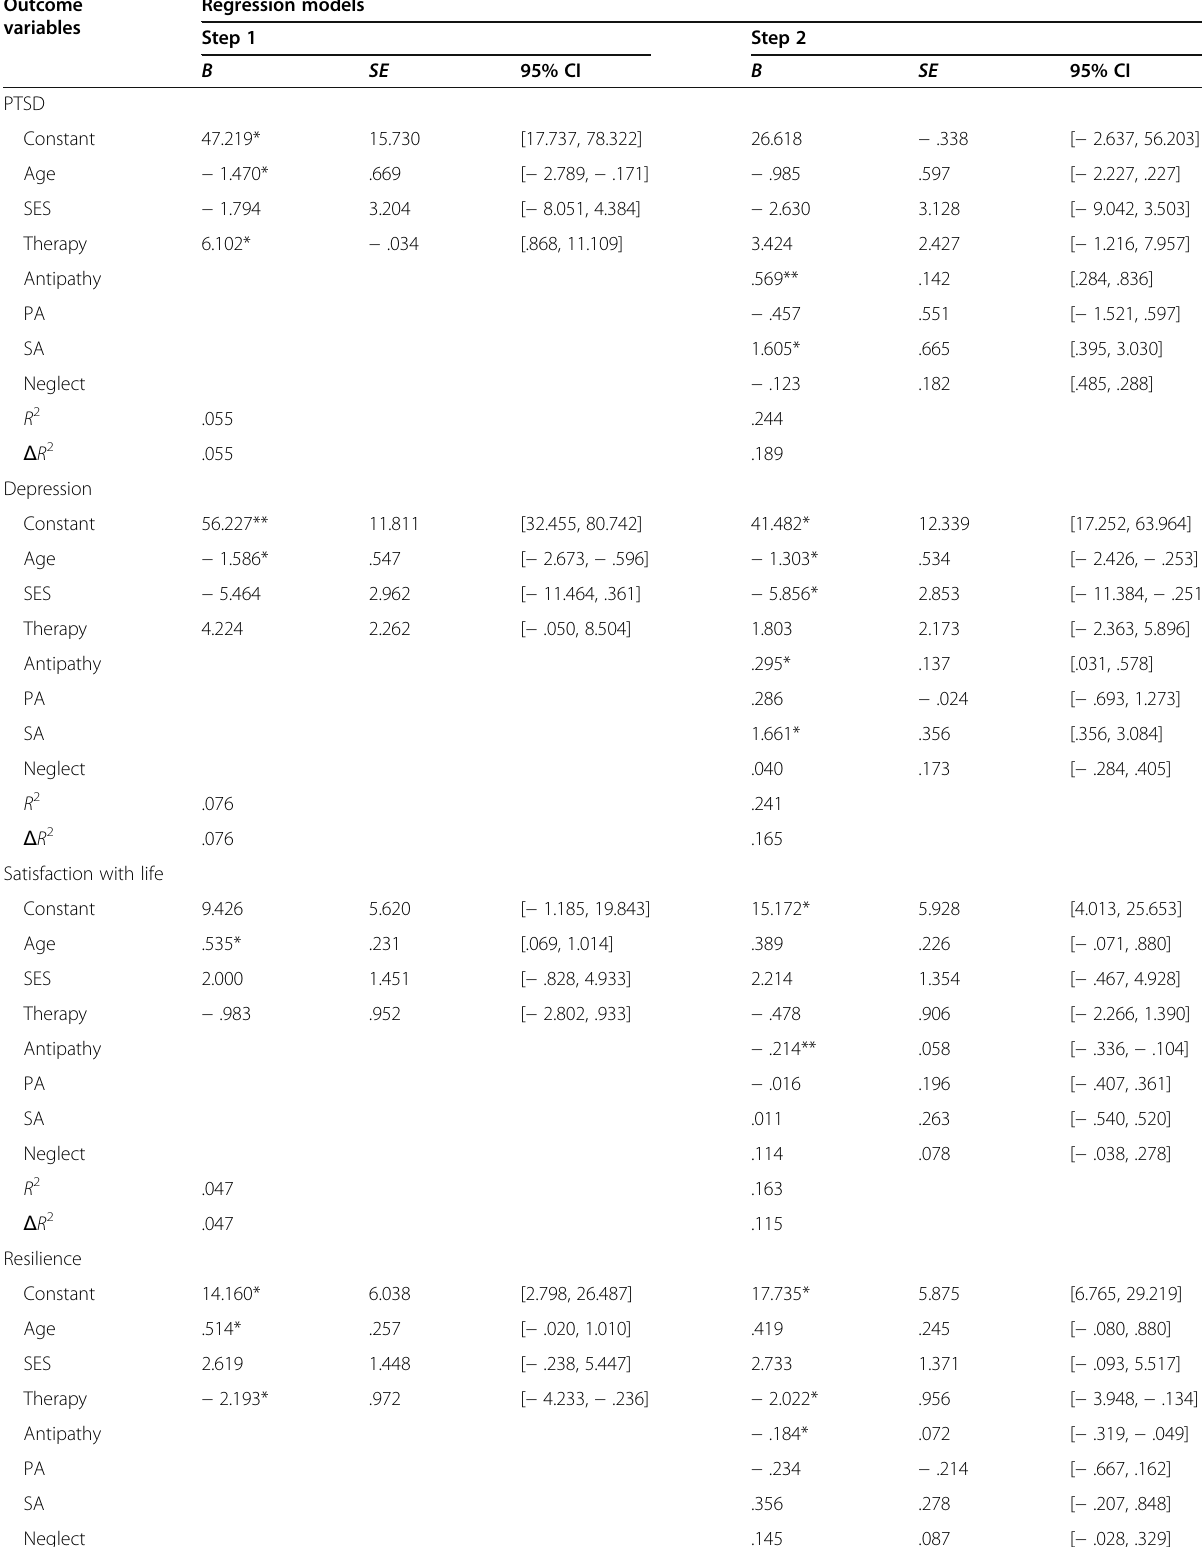
Table 3 Multiple regressions with covariates and CM predicting PTSD, depressive symptoms, resilience, and life satisfaction Outcome